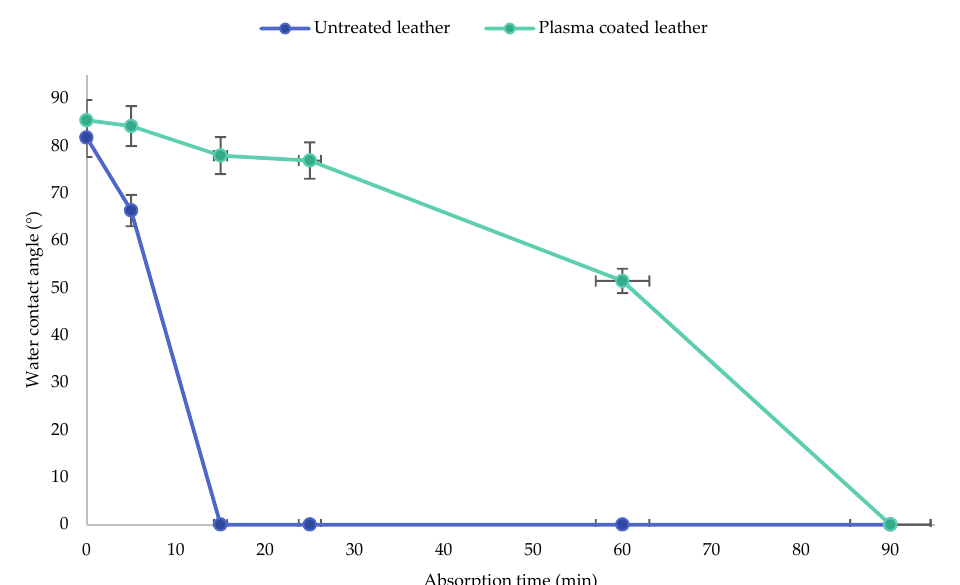
Figure 9. Evolution of wettability of untreated and plasma treated samples over time.